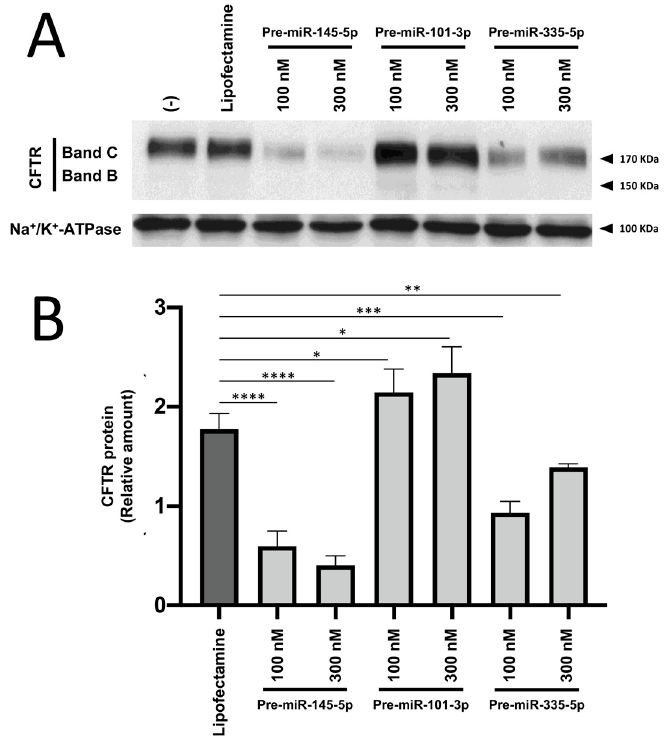
Figure 2. Effects of treatment of Calu-3 cells with pre-miR-145-5p, miR-101-3p, and miR-335-5p. Treatment was 72 h. ( A ). Representative Western blotting gel images. ( B ). Relative values of CFTR content with respect to Na+/K+-ATPase. The uncut version of the gel is shown in Supplementary Figure S1. (-) = untreated cells. * p < 0.05, ** p < 0.01, *** p < 0.001, and **** p < 0.0001.